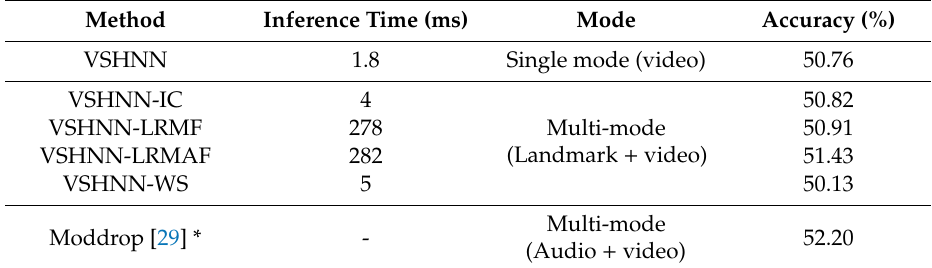
Table 10. Performance evaluation of multi-modal fusion for AFEW dataset. * Note that Moddrop uses an additional audio modality. Note that interference time was measured based on batch size of 32.